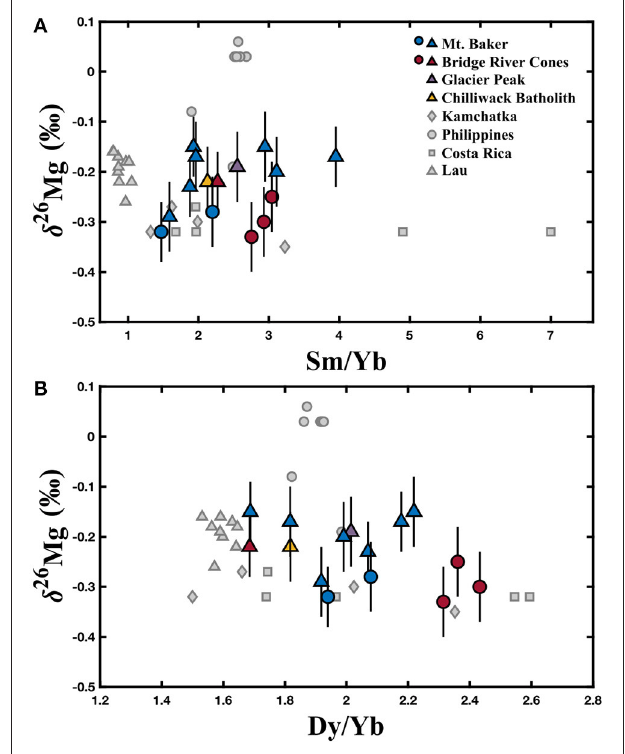
FIGURE 4 | Variation of δ 26 Mg with (A) Sm/Yb and (B) Dy/Yb ratios. The colored circles represent those samples identified as most primitive from Mt. Baker and the Bridge River Cones, while the colored triangles represent samples that exhibit crustal contamination. North Cascades data are reported in Table 1 . Literature data are represented by gray symbols and are from Li et al. (2017). Error bars represent the 2 SD for each North Cascades sample.